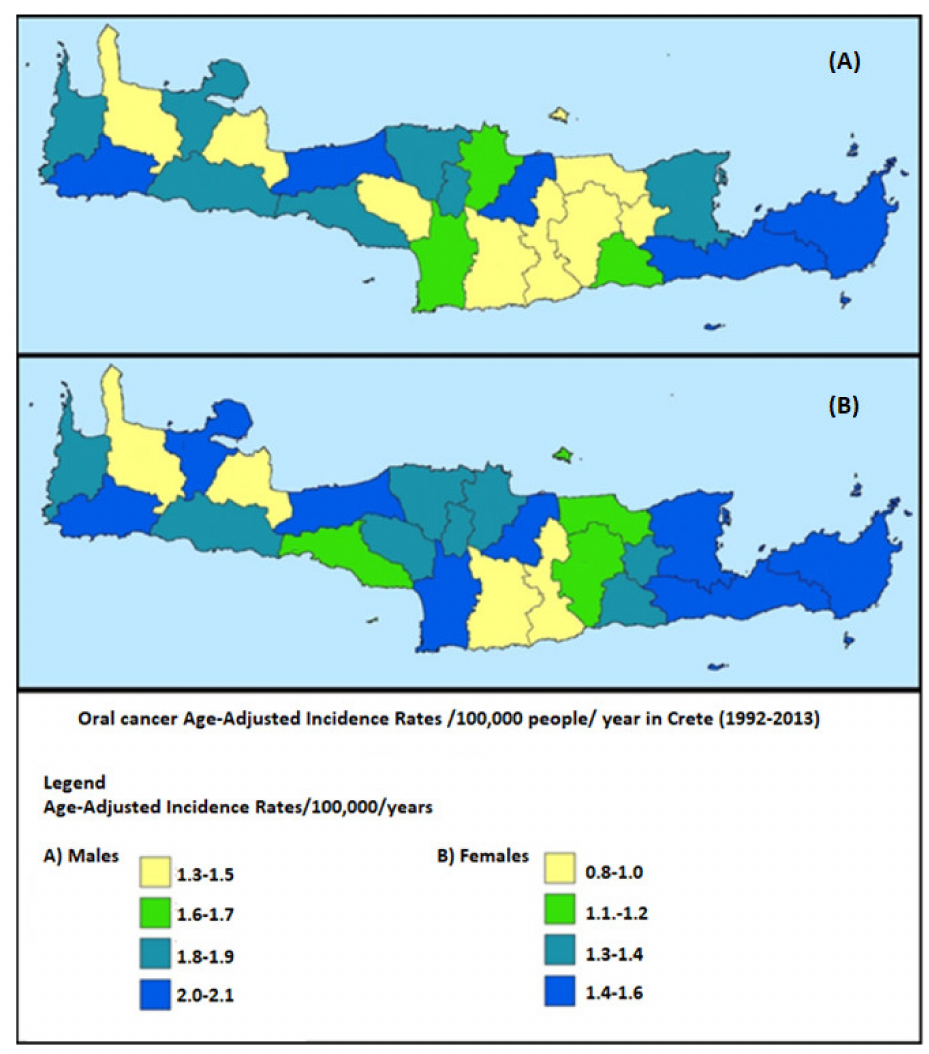
Figure 2. Geographical distribution of oral cancer Age-Standardized Incidence Rates/100,000/year in Crete, (Source: Cancer Registry of